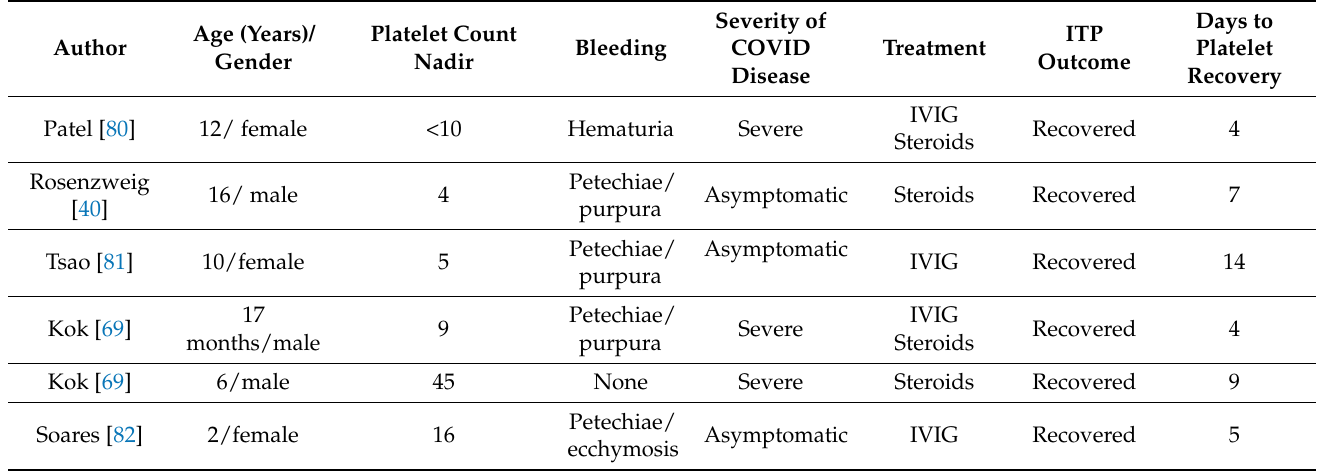
Table 3. Reported cases of SARS-CoV-2 -associated ITP in